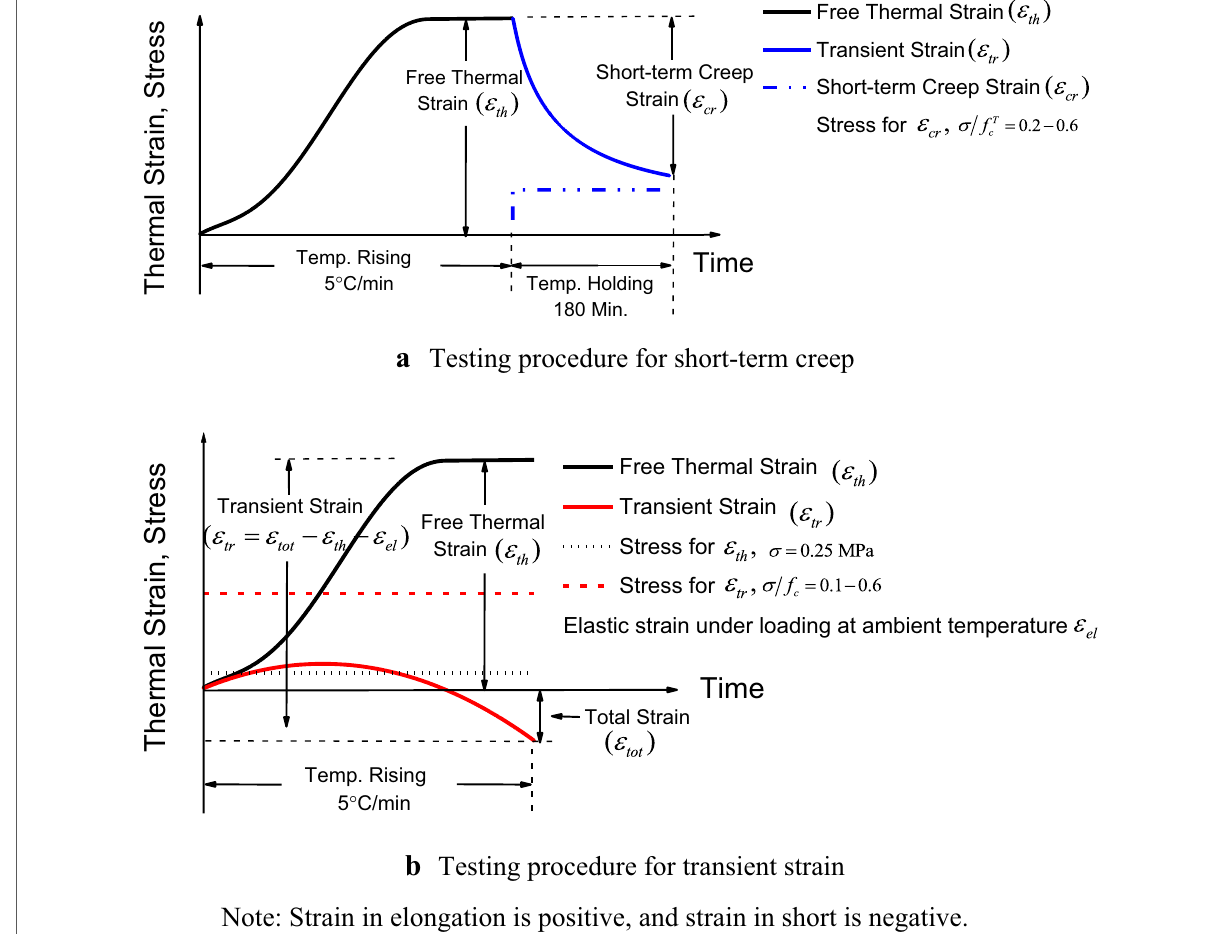
Fig. 5 Testing procedure for creep behaviour at high